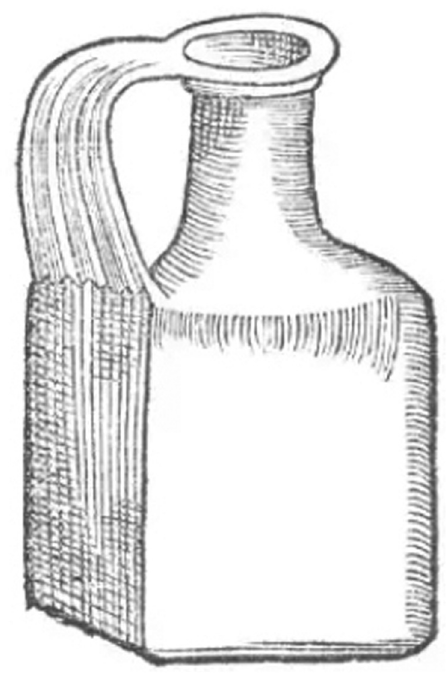
Figure 3: Engraving of a Roman glass vessel from Voorburg - Arentsburg ( The Netherlands ) with typical, unnatural emphasis on important features such as the rim and handle, published in Inferiores Germaniae Provinciarum Unitarum antiquitates by P. Scriverius, 1611. Courtesy of Leiden University Libraries [ 392 B 2 ]